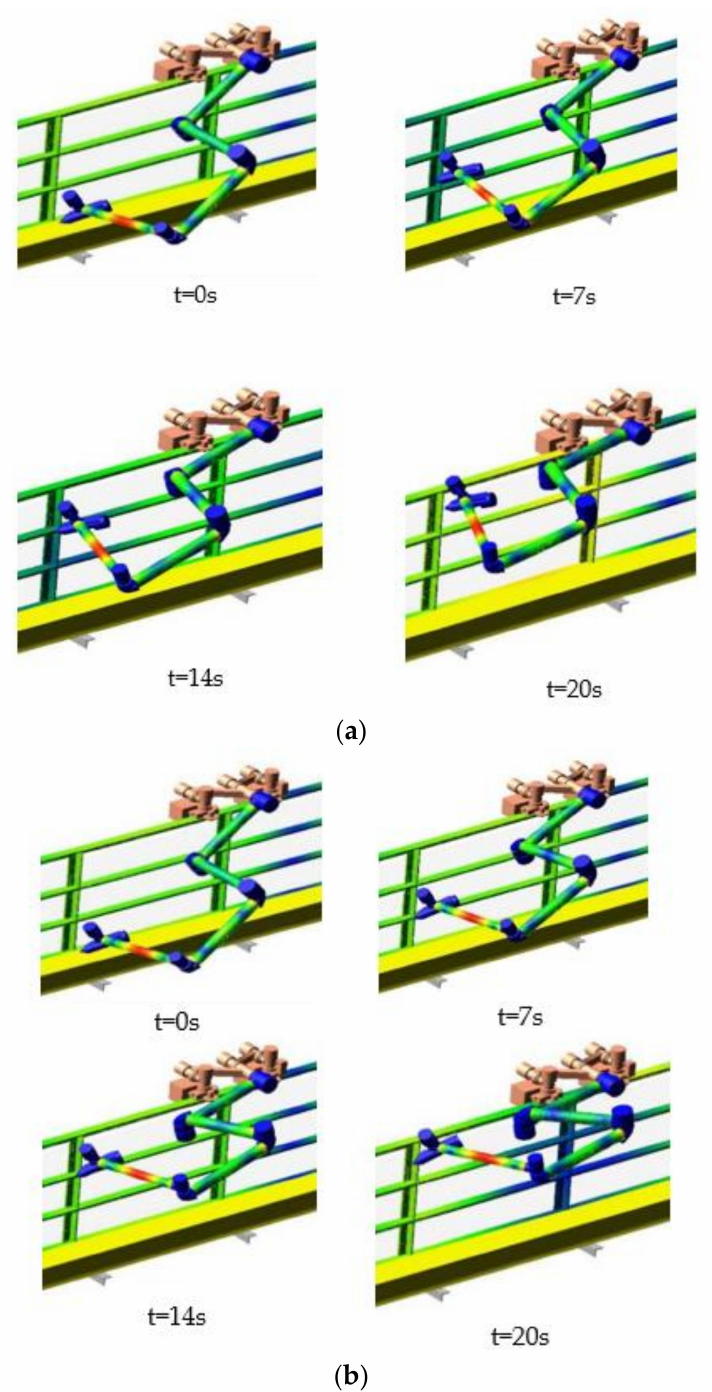
Figure 25. Screenshots of the simulation. ( a ) Without optimization, ( b ) With optimization. The tracking errors of the end effector in the simulation are shown in Figure 26. It can be clearly seen that the tracking errors of the trajectory with optimization are smaller than the tracking errors of the trajectory without optimization. The mean deviation and standard deviation of the tracking errors in linear working path simulation are shown in Table 5. It can be calculated from Table 5 that, the absolute value of the mean deviation of the tracking errors of the X-axis, Y-axis, and Z-axis decreased by 65.5%, 48.3%, and 52.4%, respectively, with vibration-reduction optimization. The results indicate that the proposed algorithm can markedly reduce the vibration along the linear working